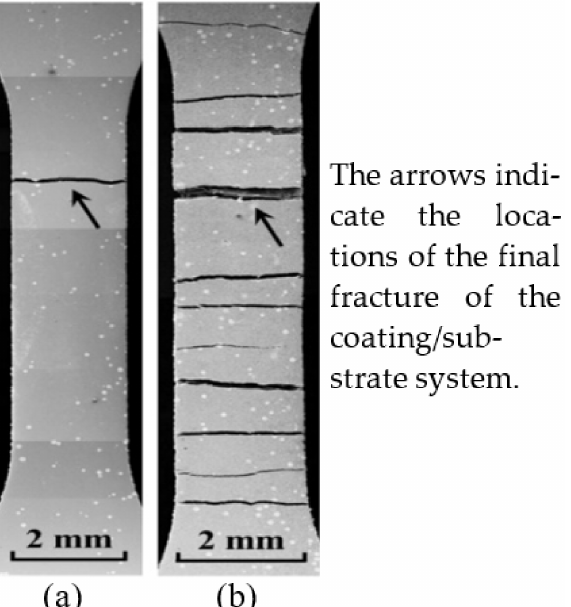
Figure 2. Crack patterns observed by SEM at the composite coating surface with ( a ) 4.10 vol% and ( b ) 13.95 vol% WC particles at the time of the test samples about to be broken